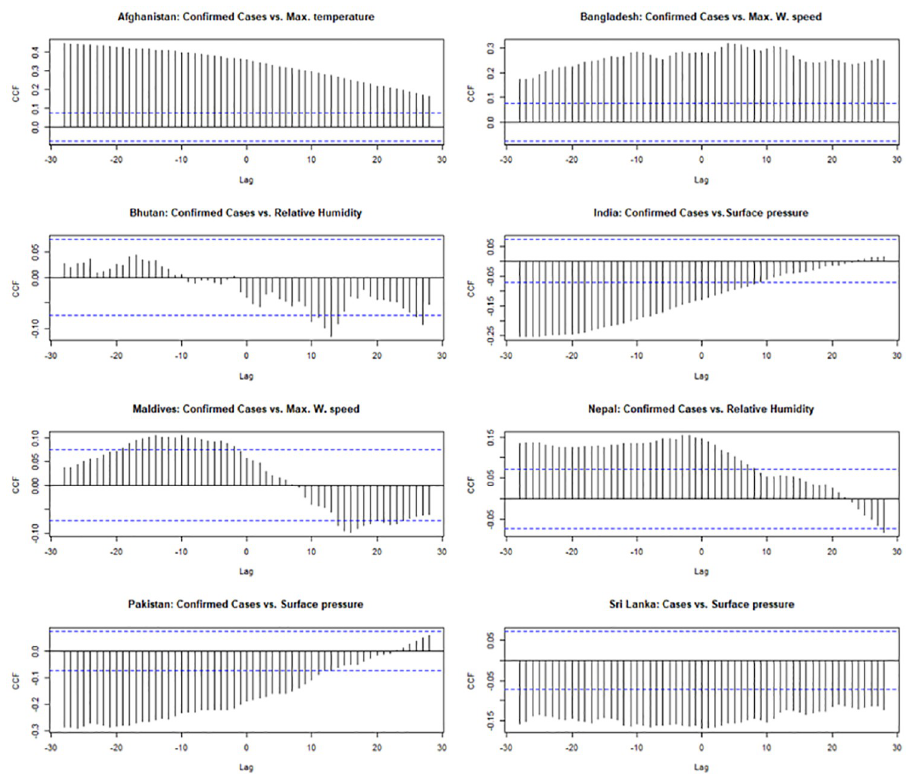
Fig 4. Cross-correlation between COVID-19 confirmed cases and meteorological variables in SAARC countries. Max. temperature: Maximum temperature; Max. W. speed: Maximum Wind speed; CCF: Cross-Correlation Function.